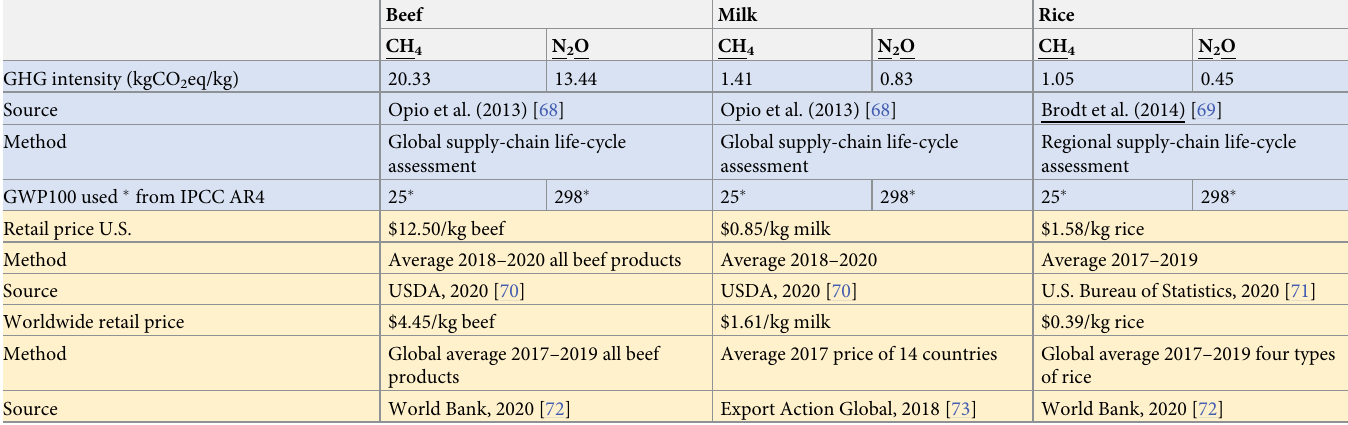
Table 2. Methane and nitrous oxide intensities and United Stated and global retail prices for beef, milk, and rice. Beef Milk Rice CH 4 N 2 O